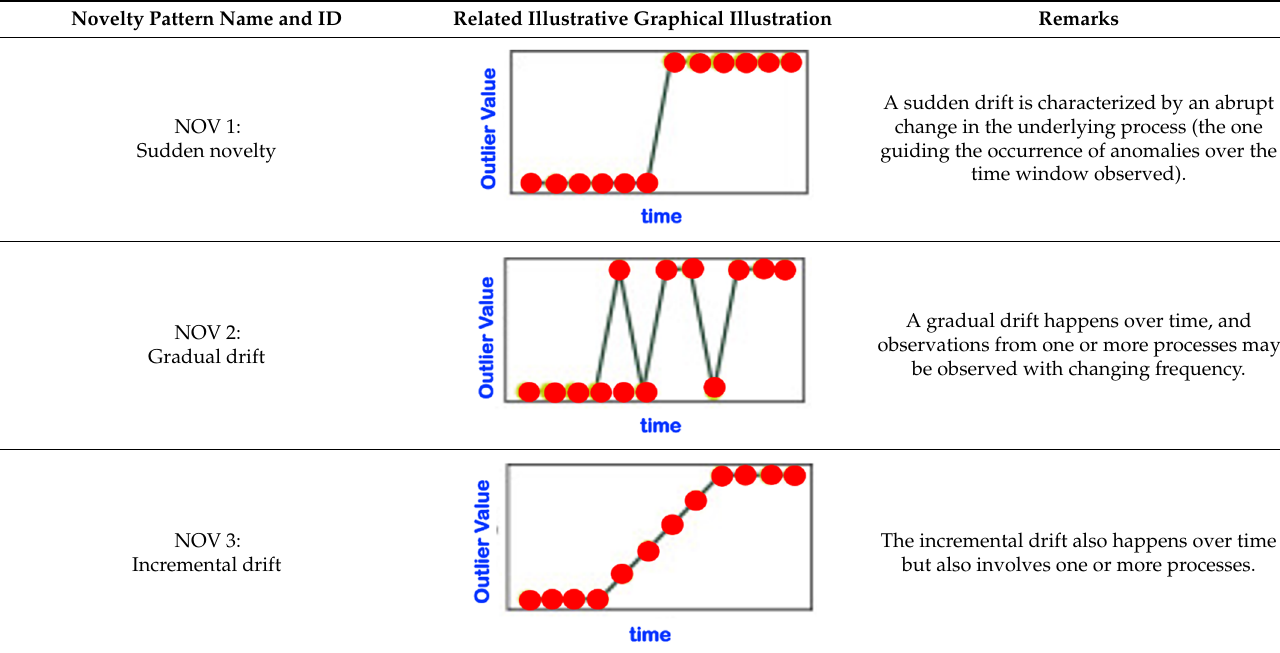
Table 3. Temporal view of the novelty patterns—some illustrative examples (non-exhaustive).